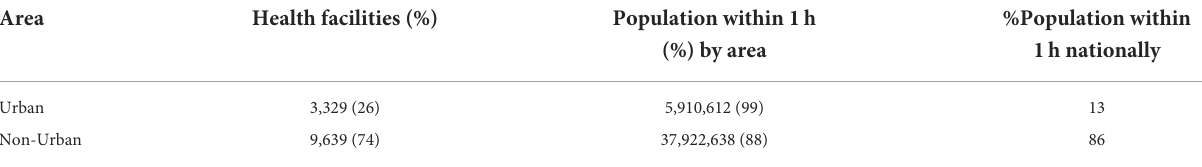
%Population within (%) by area 1 h